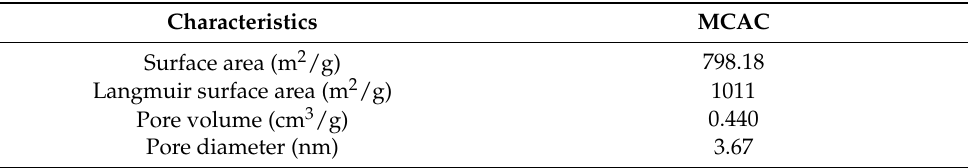
Table 3. BET analysis results of MCAC adsorbent.